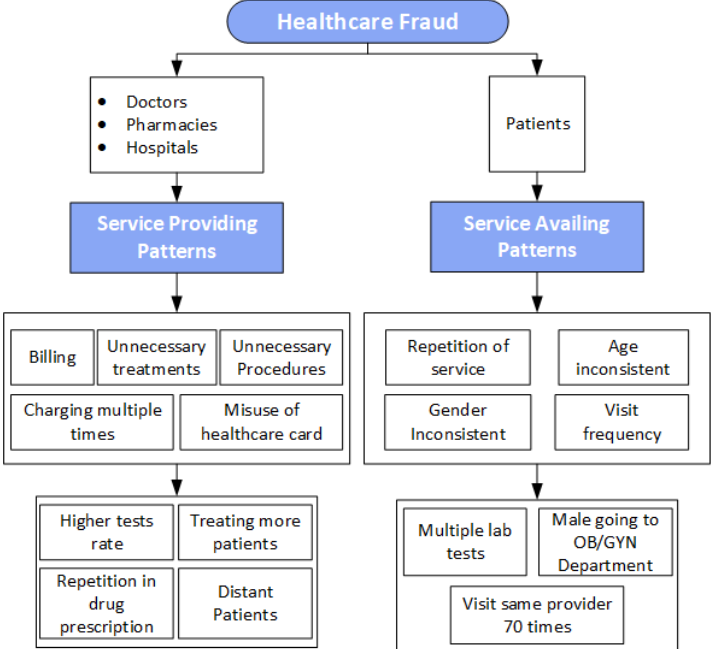
Figure 1. The Figure 1 explains two categories of healthcare frauds: Frauds in Service availing patterns(Patients) and Frauds in Service providing patterns(Doctors, pharmacies,